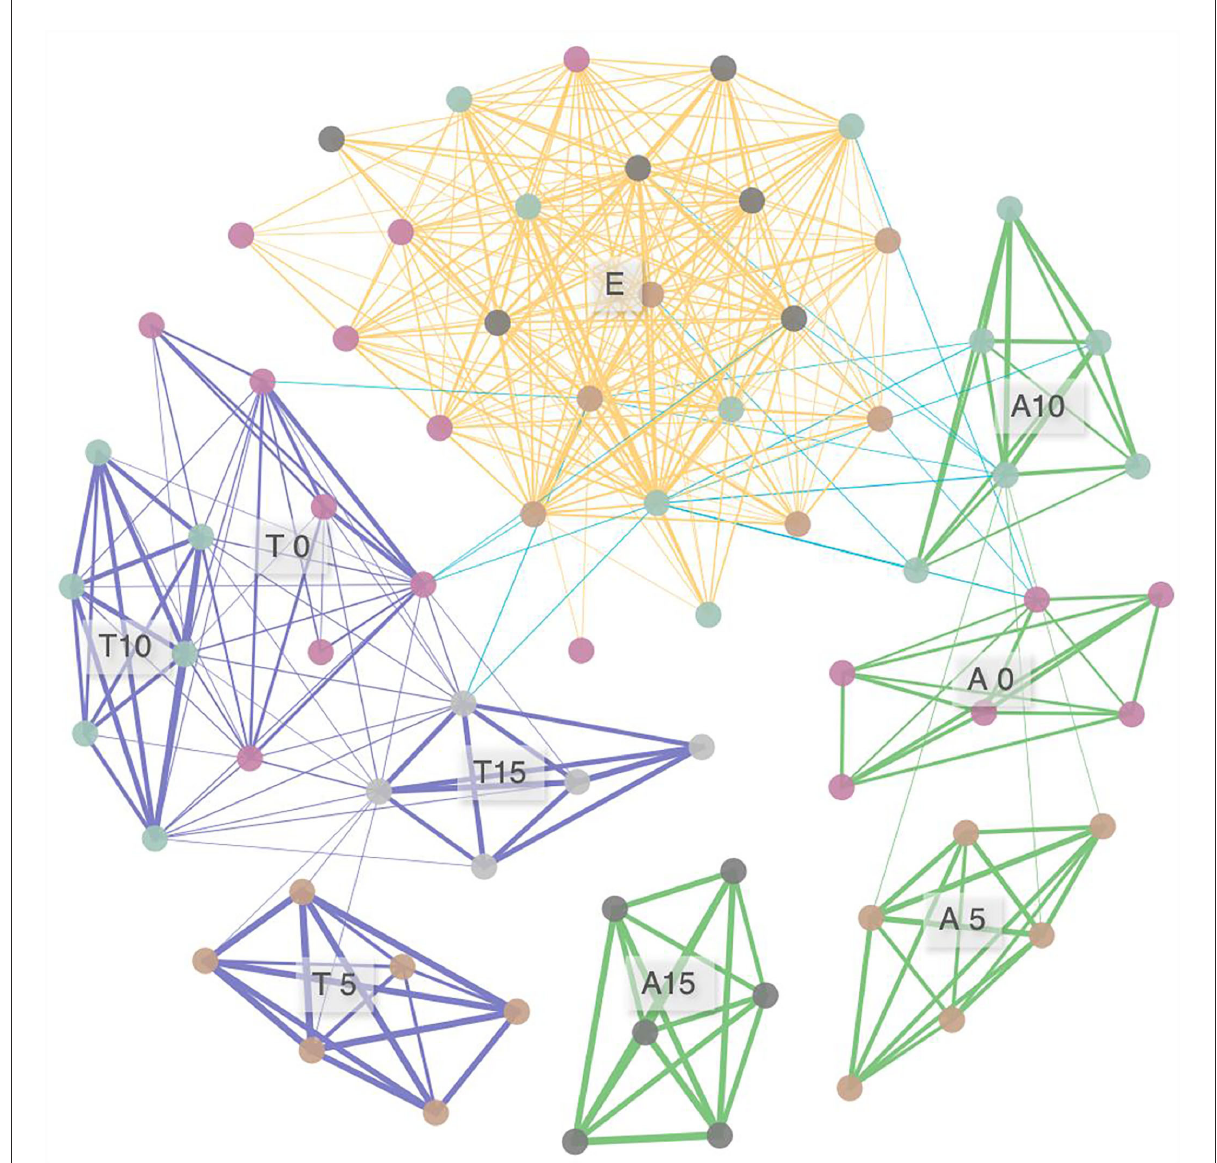
FIGURE5 Networks of taxa similarity in three species along the nitrogen enrichment gradients, based on correlation analysis. A connection stands for a correlation with Spearman’s ρ > 0.4 and p < 0.05. The thickness of each connection between two nodes (i.e., edge) is proportional to the value of Spearman’s correlation coefficients ranging from 0.40 to 0.93. A, Anemone rivularis ; E, Elymus nutans ; T, Thermopsis lanceolata . 0 (control), 5, 10, and 15 referring to 0, 5, 10, and 15 g N (NH 4 NO 3 ) m − 2 yr − 1 treatments,